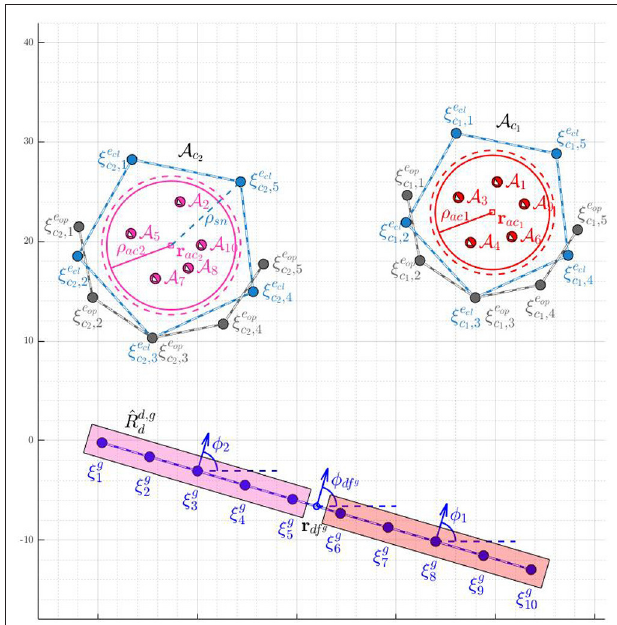
FIGURE 3 | Assignment of defenders to the attackers’